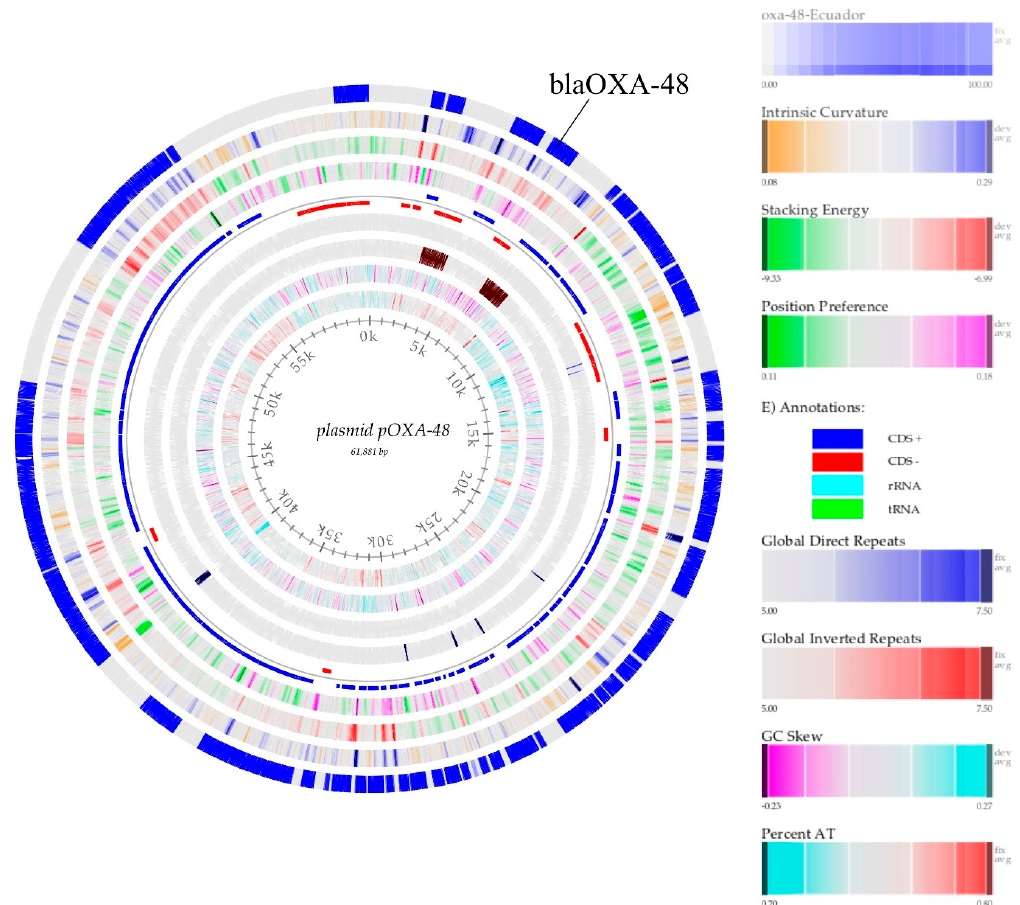
Figure 1. From center to outside, the circular map of plasmid pOXA-48 reference CP034283.1 outside in blue plasmid, pOXA-48 from Ecuador, intrinsic curvature, stacking energy, position preference, CDS+, CDS-, global inverted repeats, GC content, GC skew, and percent AT.